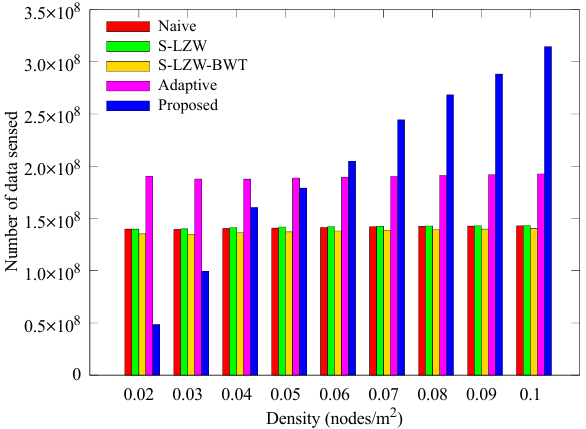
Figure 9. Change in the number of data sensed with various node densities.